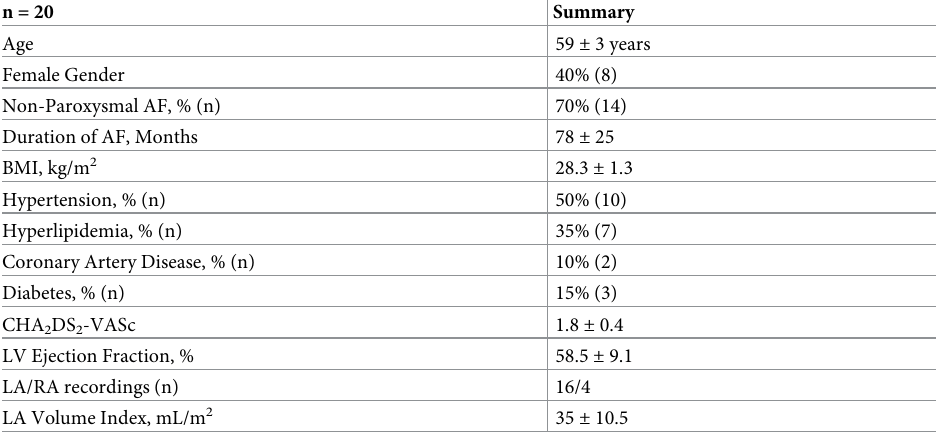
Table 1. Patient